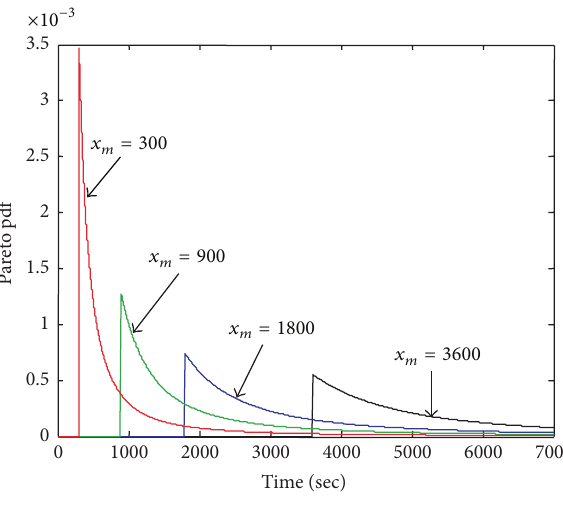
Figure 8: Total comfort cost versus 𝐶 𝑖 . The occupation time of zone I is Gamma distributed.